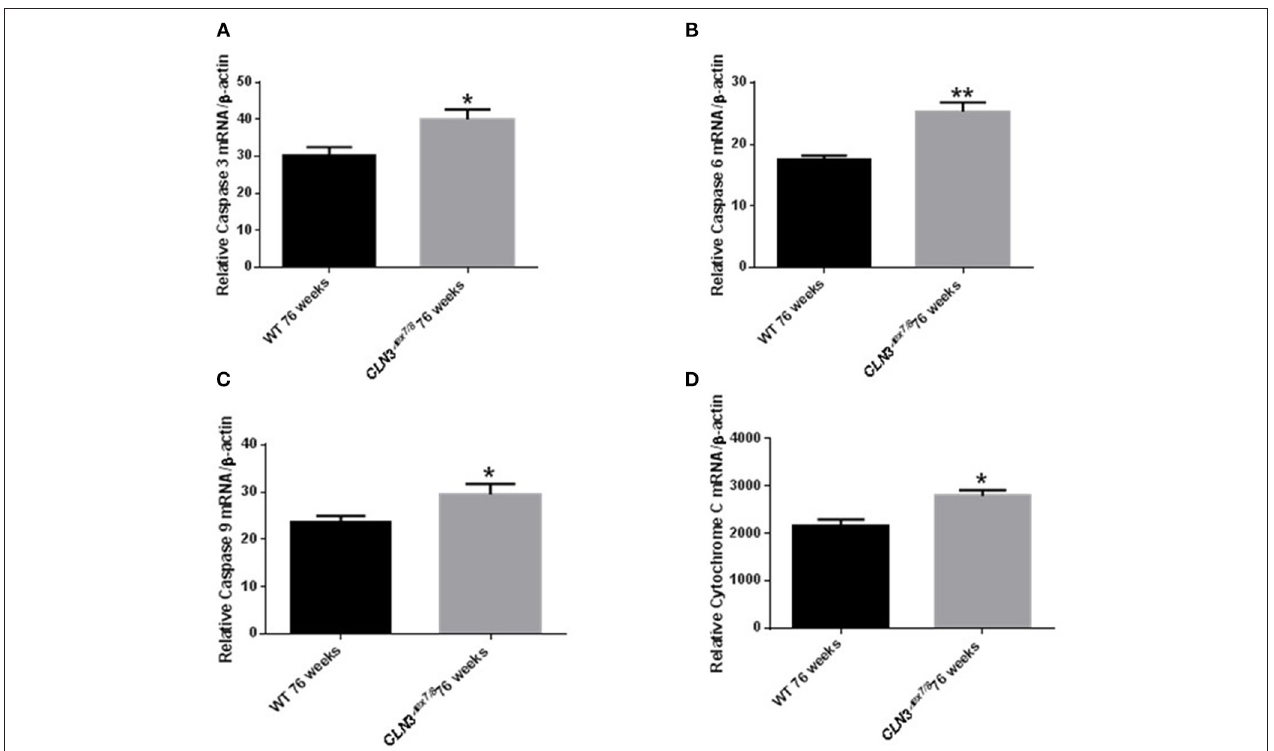
FIGURE 8 | Relative mRNA expression of apoptosis markers Caspases 3 (A) , 6 (B) , 9 (C), and cytochrome C (D) in WT and Cln3 ∆ ex7/8 mouse brain at 76 weeks of age ( n = 4 in each group) by qRT-PCR. Caspases 3 (* P < 0.05), 6 (** P < 0.01), 9 (* P < 0.05) and cytochrome C (* P < 0.05) are substantially upregulated in Cln3 ∆ ex7/8 mouse brains compared to age-matched WT mice at 76 weeks of